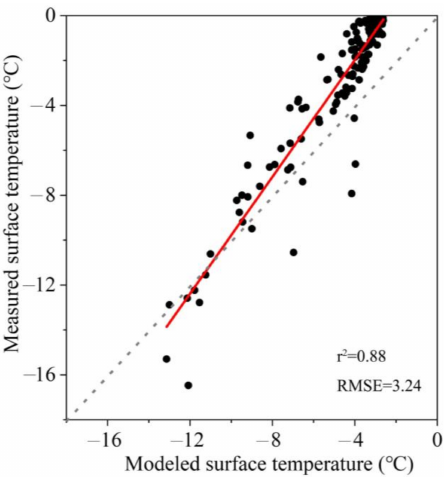
Figure 7. Comparison of daily measured and modeled surface temperatures over the whole simulation period. The grey dashed line and red line are the 1:1 line and the regression line,